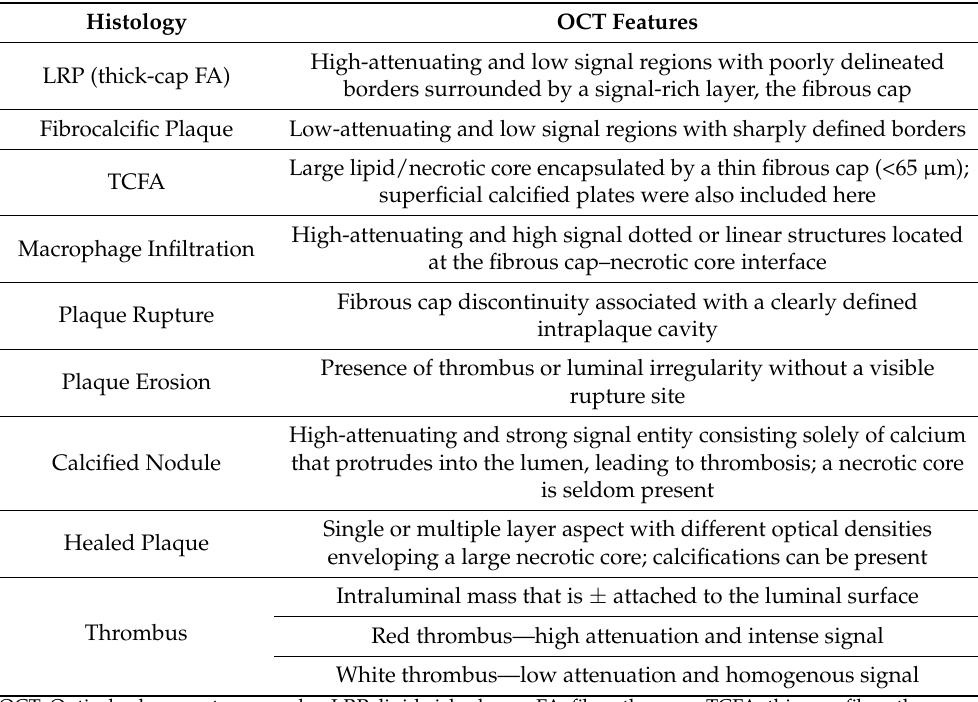
Table 1. OCT definition of main morphological patterns (adapted from Otsuka F et al. [27], Tearney GJ et al. [26], Subban V et al. [28], and Spinu M et al. [8]). Histology OCT Features High-attenuating and low signal regions with poorly delineated LRP (thick-cap FA) borders surrounded by a signal-rich layer, the fibrous cap Fibrocalcific Plaque Low-attenuating and low signal regions with sharply defined borders Large lipid/necrotic core encapsulated by a thin fibrous cap (<65 µ m); TCFA superficial calcified plates were also included here High-attenuating and high signal dotted or linear structures located Macrophage Infiltration at the fibrous cap–necrotic core interface Fibrous cap discontinuity associated with a clearly defined Plaque Rupture intraplaque cavity Presence of thrombus or luminal irregularity without a visible Plaque Erosion rupture site High-attenuating and strong signal entity consisting solely of calcium Calcified Nodule that protrudes into the lumen, leading to thrombosis; a necrotic core is seldom present Single or multiple layer aspect with different optical densities Healed Plaque enveloping a large necrotic core; calcifications can be present Intraluminal mass that is ± attached to the luminal surface Thrombus Red thrombus—high attenuation and intense signal White thrombus—low attenuation and homogenous